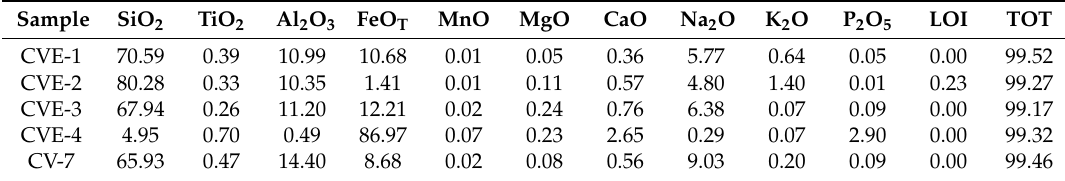
Table 1. Major element analyses by X-ray